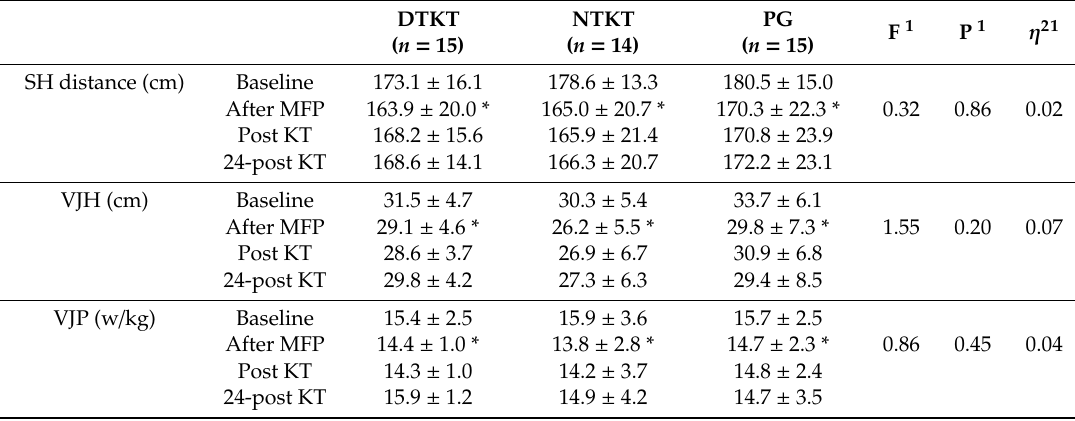
Table 3. Functional performance changes after intervention in the three groups ( N = 44). DTKT ( n =